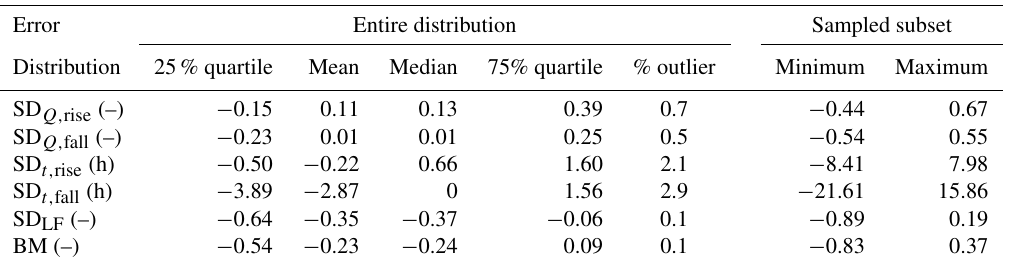
Table 2. Statistical properties of the individual Series Distance (SD) and benchmark (BM) error distributions from the case study. For the entire distribution we provide the first and third quartile, the mean, median, and the percentage of outliers (data points which are more than 3 standard deviations apart from the mean). For the subset we provide the sampled upper (maximum) and lower (minimum) boundaries. The subscripts with SD refer to errors in magnitude ( Q ) and timing ( t ) separately for the rising (rise) and falling (fall) limbs, respectively. SD LF provides results for the periods of low flow.